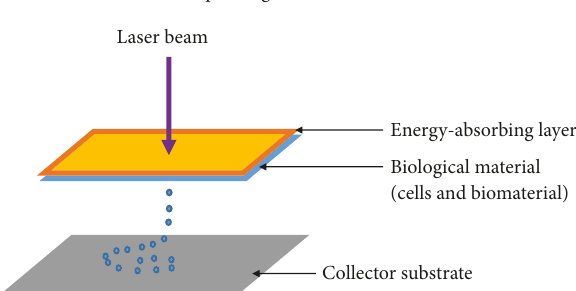
Figure 3: Laser-assisted printers are made up of a pulse laser beam which is focused on an absorbing substrate resulting in the generation of a pressure bubble that forces biological material onto the collector